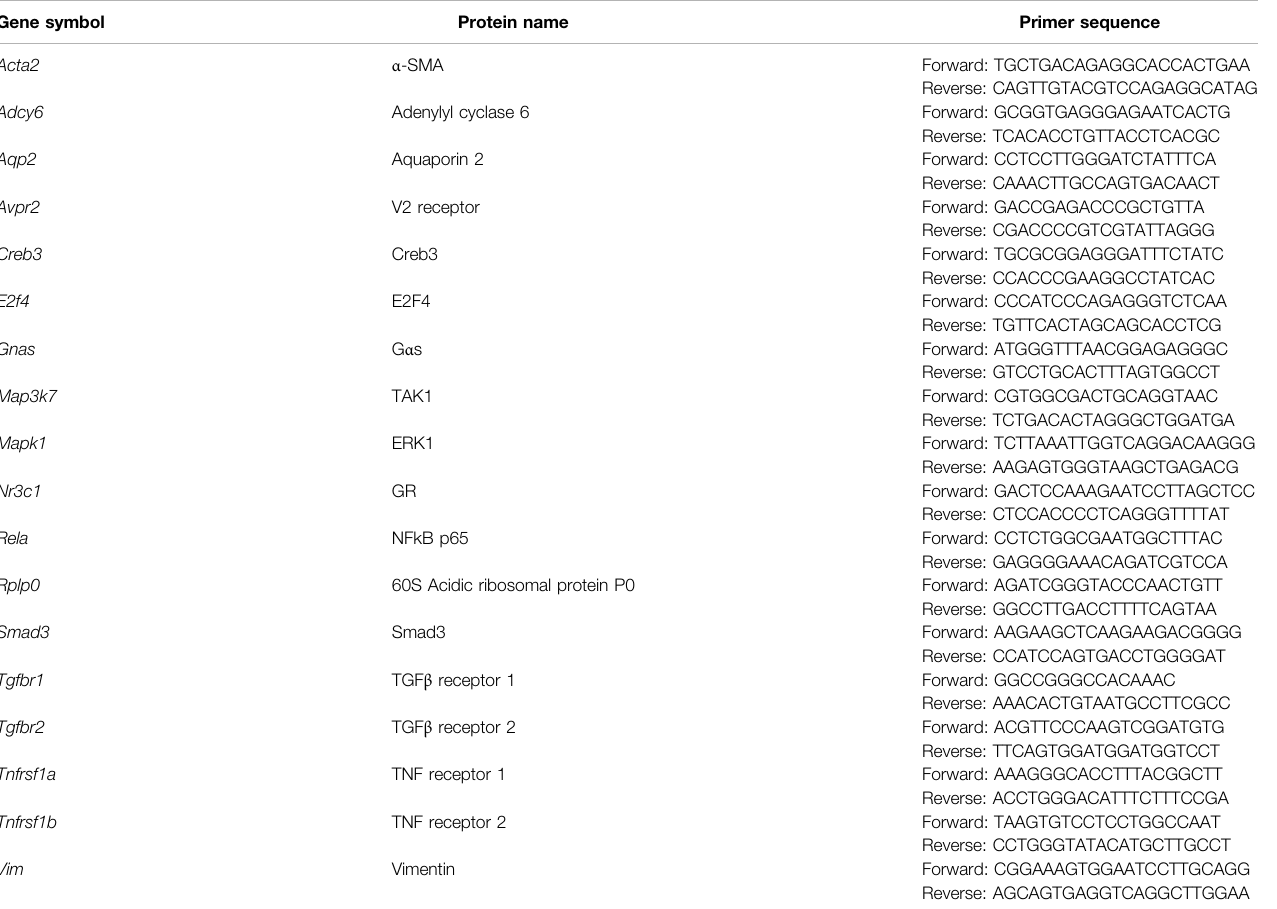
TABLE 1 | Primers used in this study. Gene